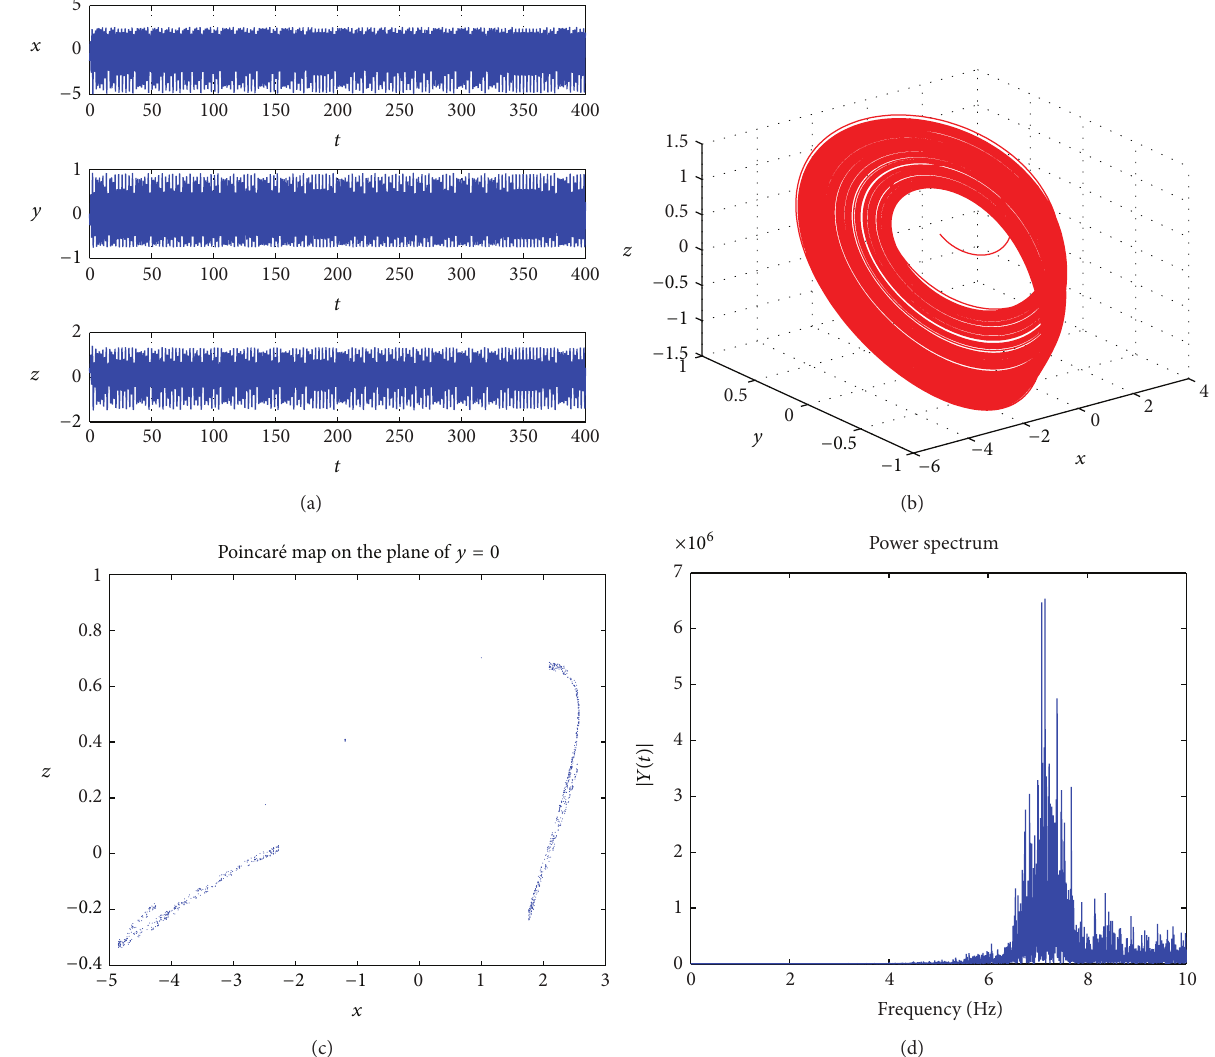
Figure 1: Chaotic attractor, Poincar´e map, and frequency spectrum of system